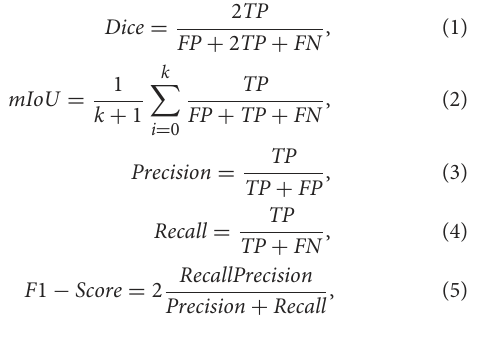
image rotation of images at 90, 180, and 270 degree angles, horizontal flip, and vertical flip (equal to predicting each image 6 times). In the end, we used the average of six prediction maps to get the final prediction map. All baseline approaches utilized the same strategy during the testing